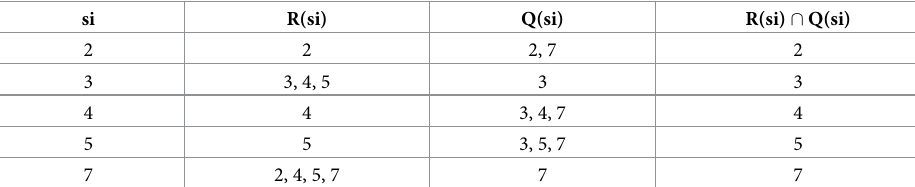
Table 6. Division of the third-level factors.